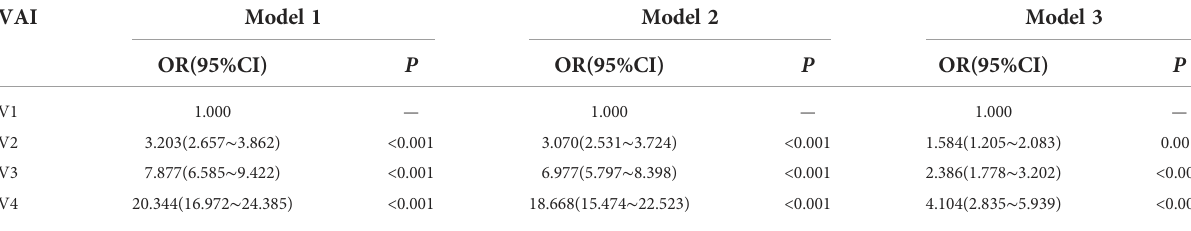
TABLE 6 Multivariate logistic regression analysis of the association between VAI and the risk of NAFLD.